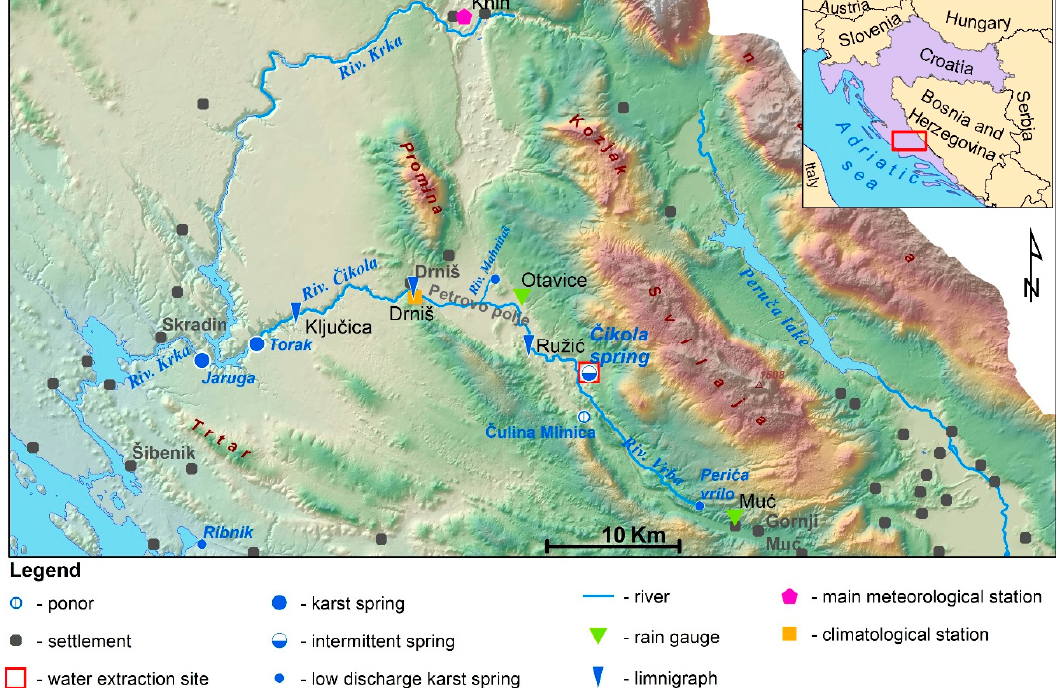
Figure 1. Research area position map with most important features.